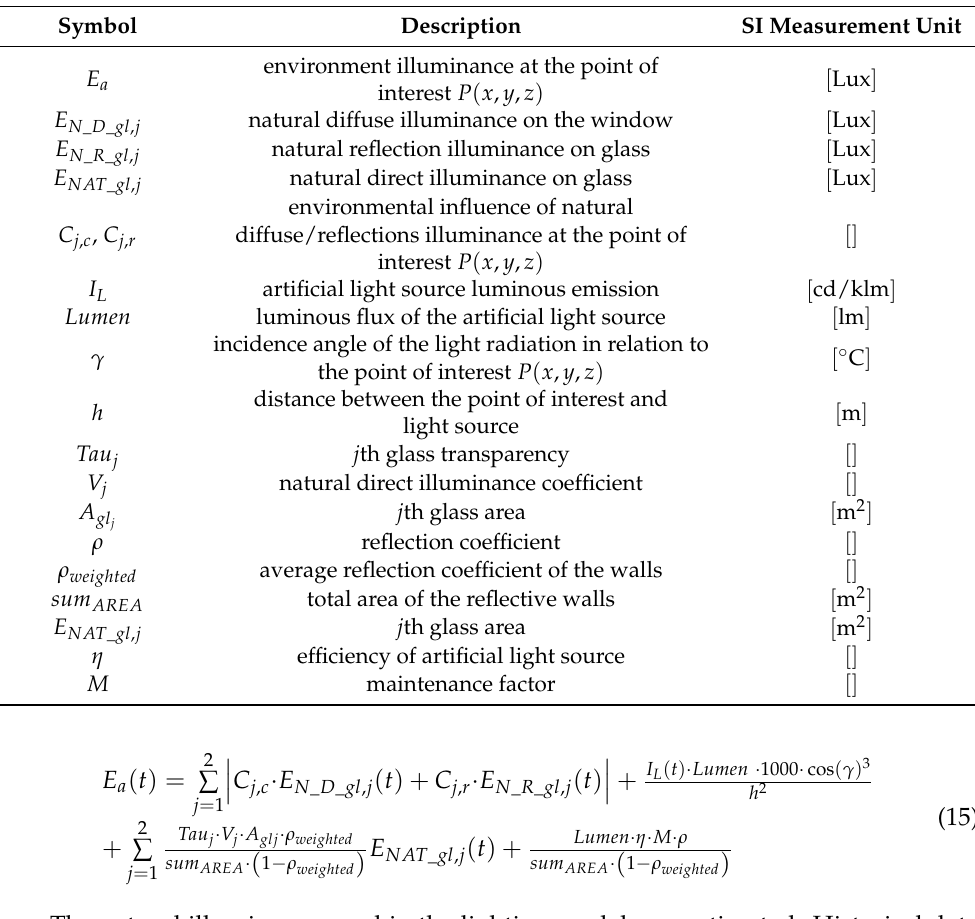
Table 6. Lighting model parameters (Equation